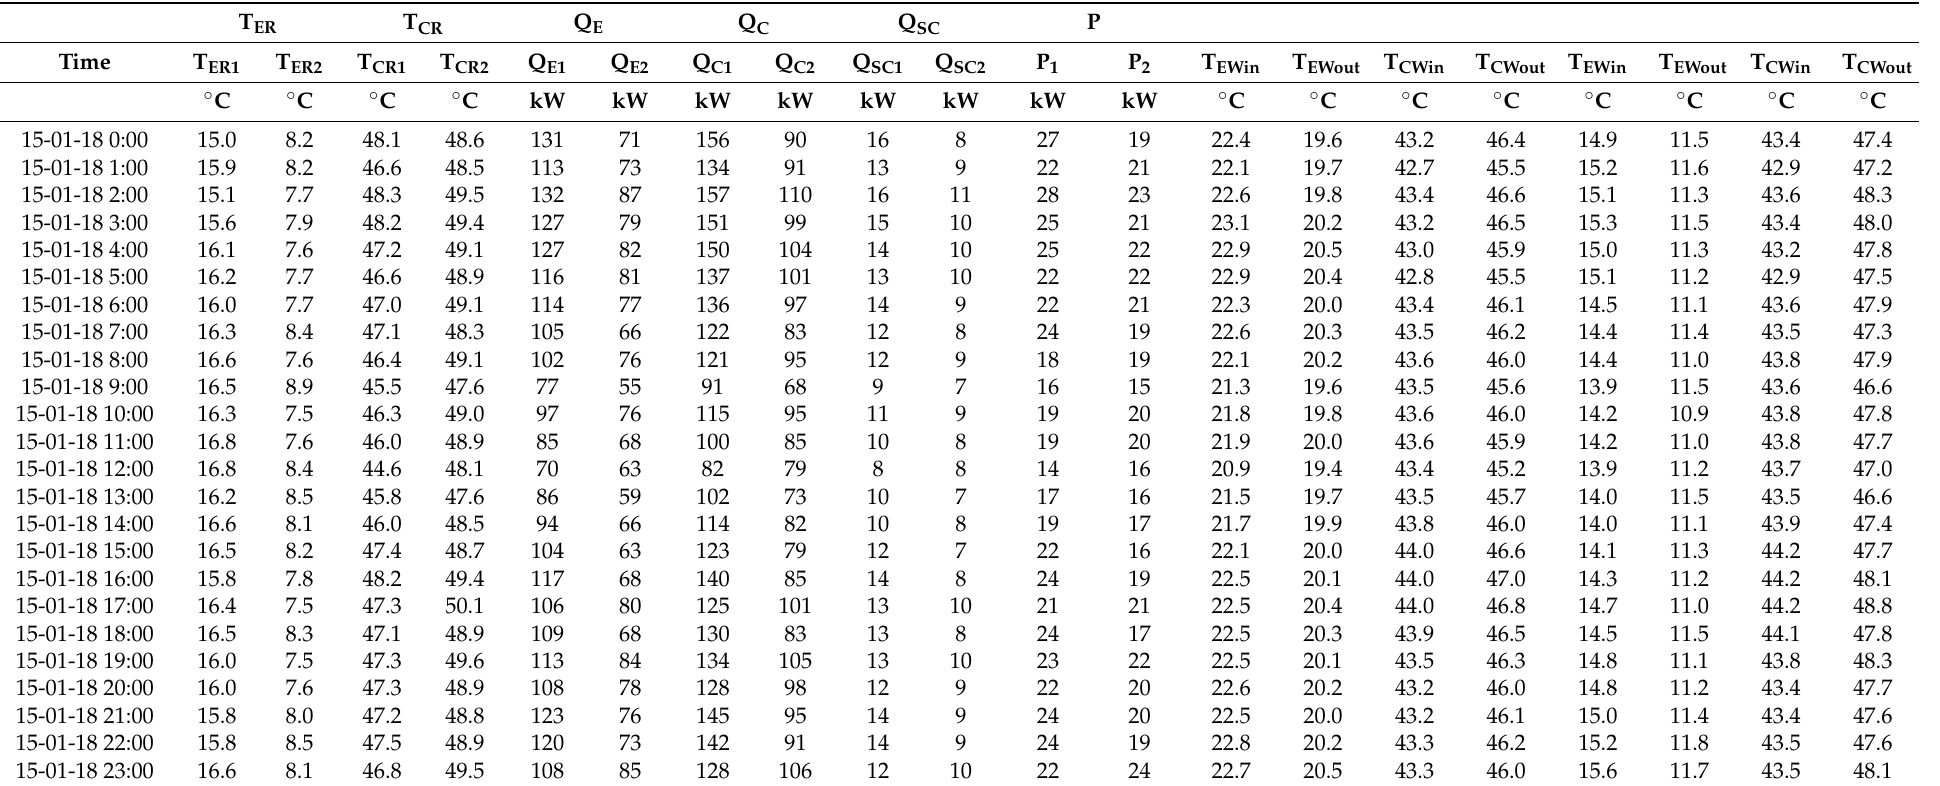
Table A3. Sample data from HP3 for a typical winter